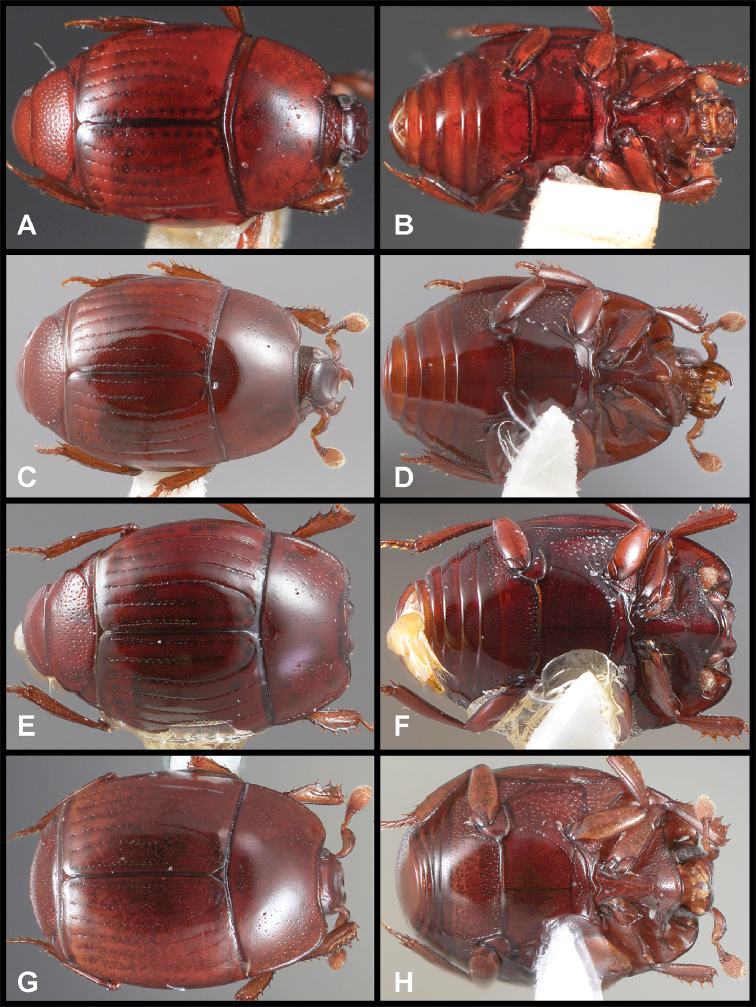
A, BPhelister
blairi Lewis: A dorsal habitus B ventral habitus. C, DP.
erwini: C dorsal habitus D ventral habitus E, FP.
fimbriatus: E dorsal habitus F ventral habitus G, HP.
stellans: G dorsal habitus H ventral habitus.